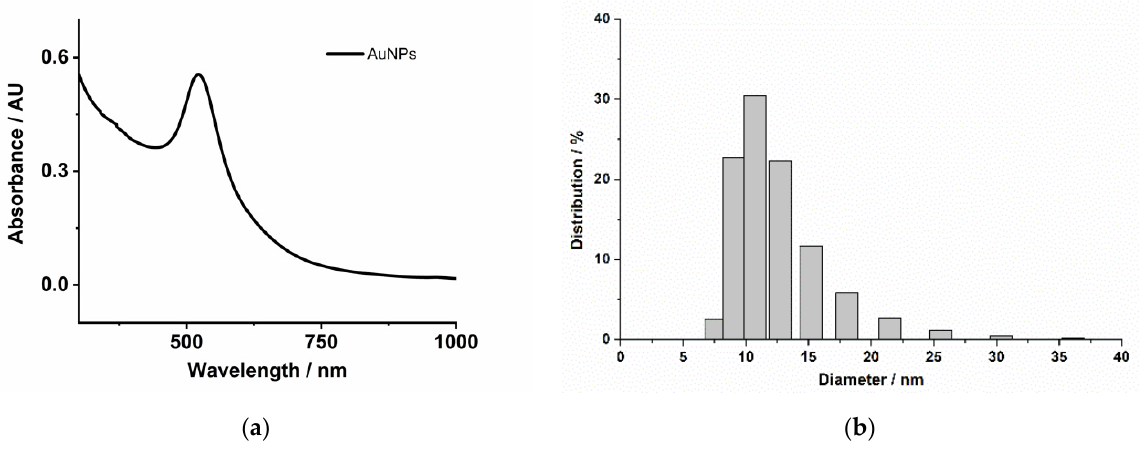
Figure 1. ( a ) UV–Vis spectrum of the gold nanoparticle solution. ( b ) Size distribution of the gold nanoparticles.